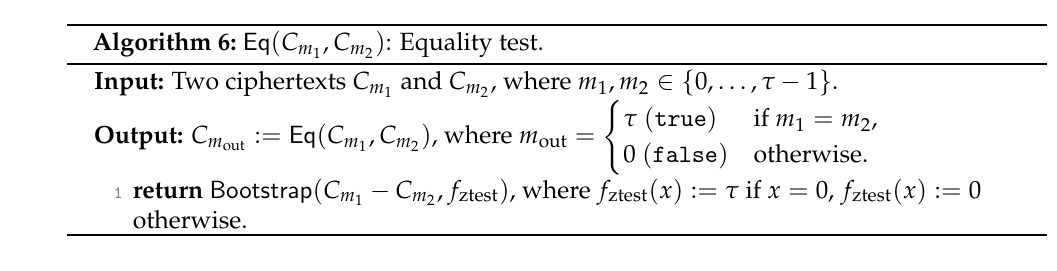
, m 2 ) : Equality test with a 1